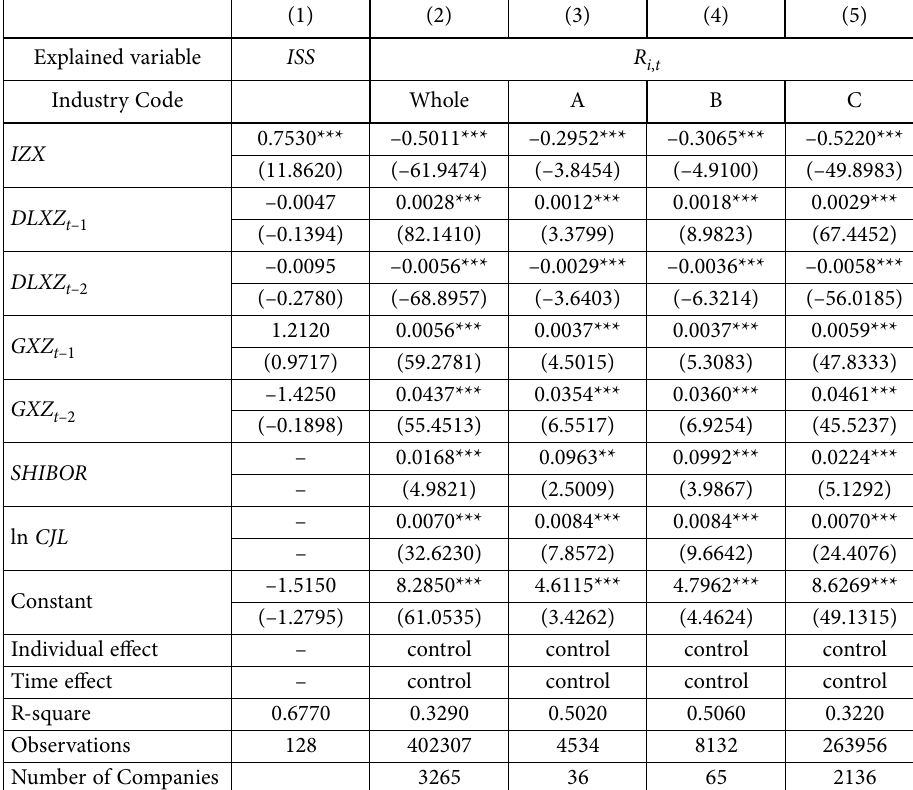
Table 4. Impact of infodemic on stock market 1